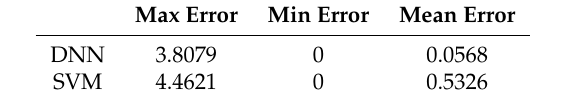
Table 3. The maximum, minimum, and mean of distance error value of the DNN and SVM.